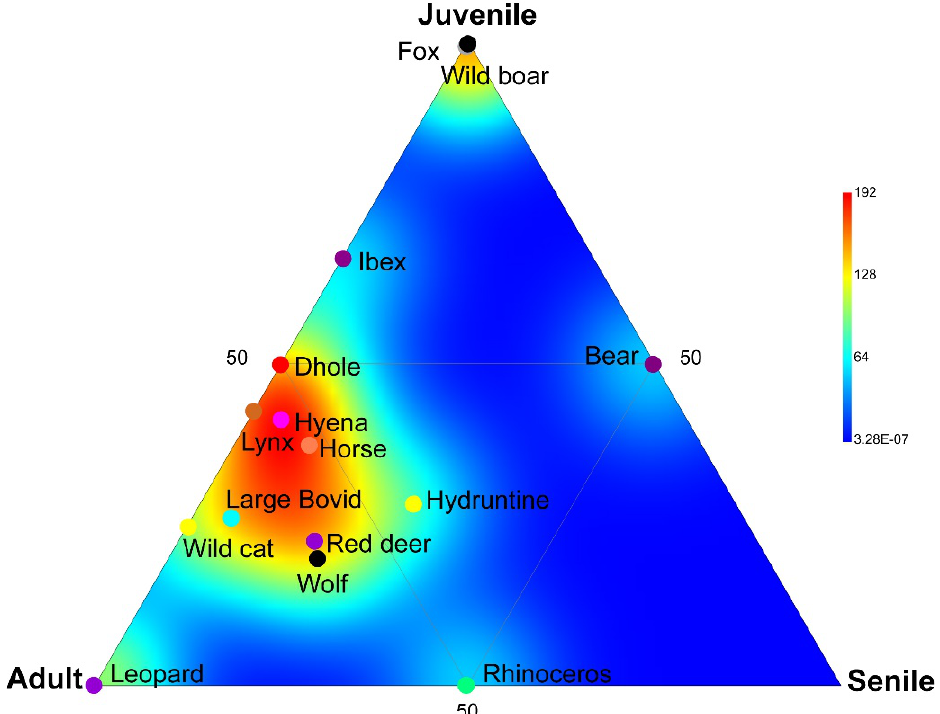
Figure 5. Ternary plot distribution of large mammals from Cova del Gegant-GL1. Dots indicate the percentage median of individuals for juveniles, adults, and senile individuals. Analysis was performed using PAST software